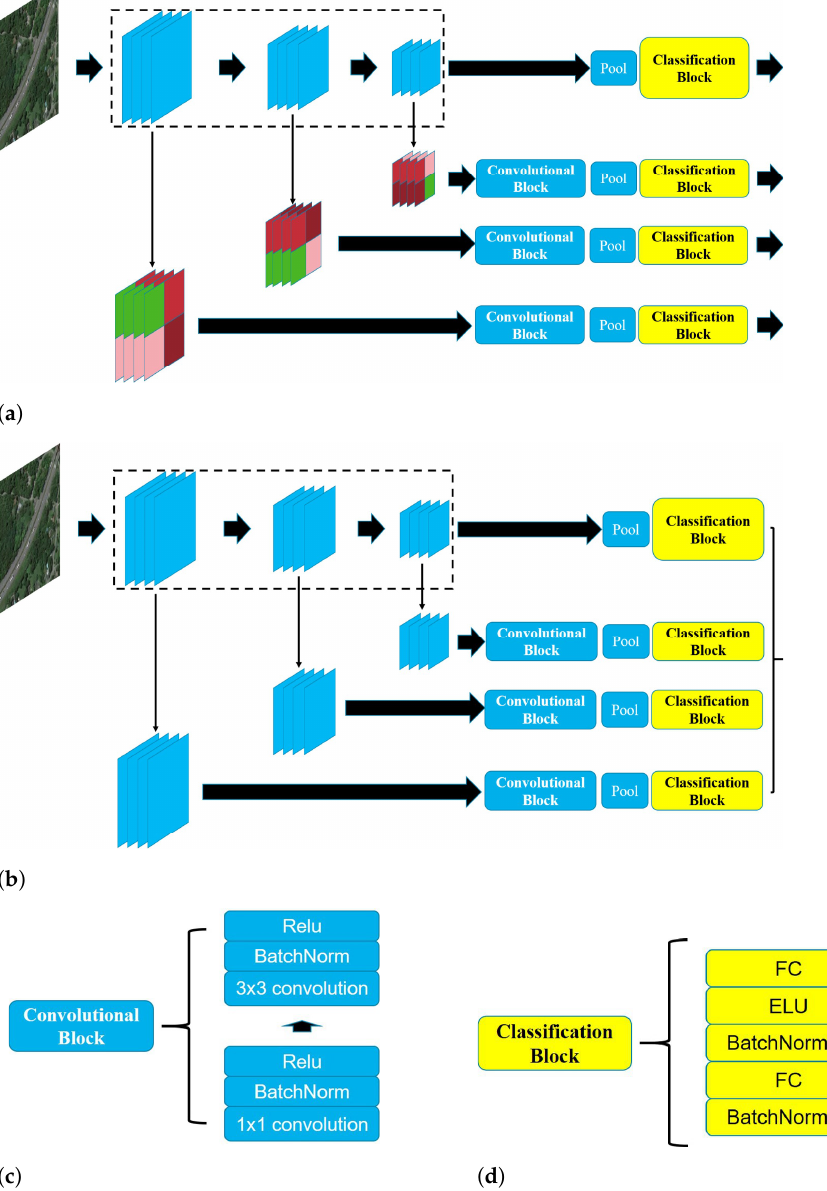
Figure 3. The proposed SMGFL-Net: ( a ) the training phase; ( b ) the inference phase; ( c ) the convolu- tional block; ( d ) the classification